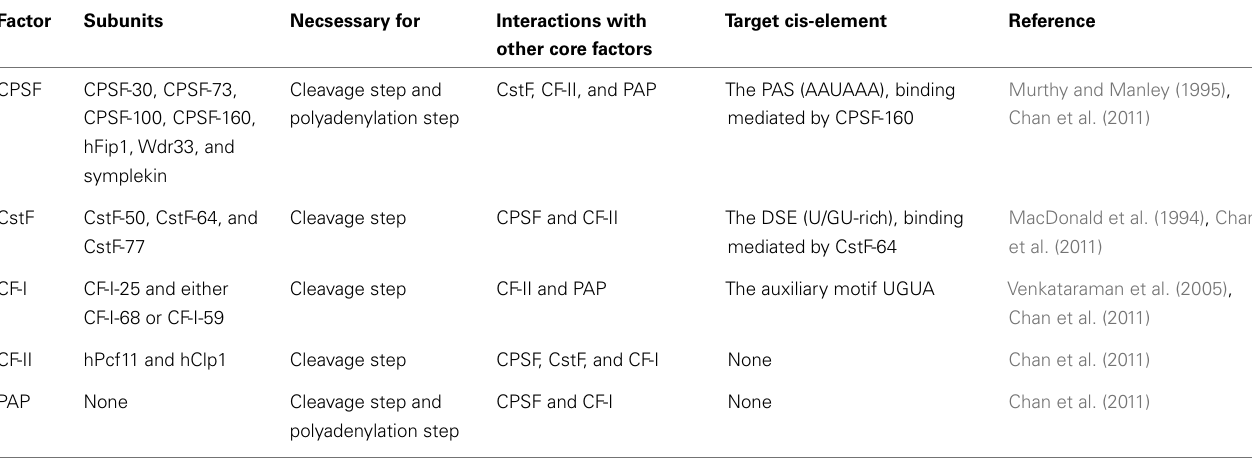
Table 1 |The core polyadenylation